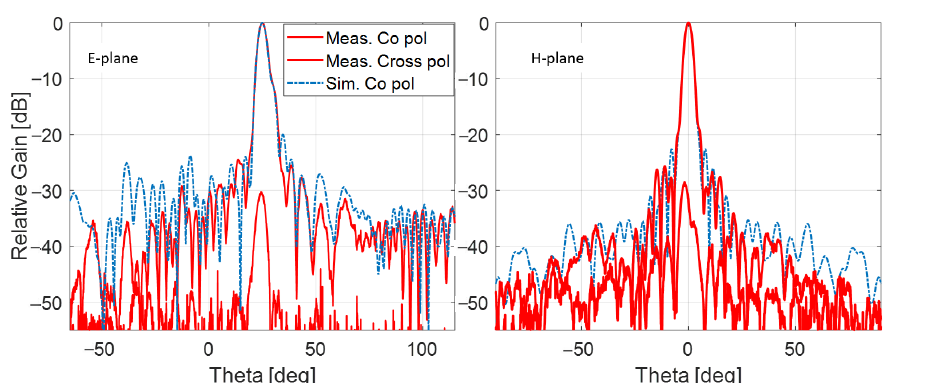
Figure 8. Radiation patterns in the E ( left ) and H ( right ) planes at 29 GHz.